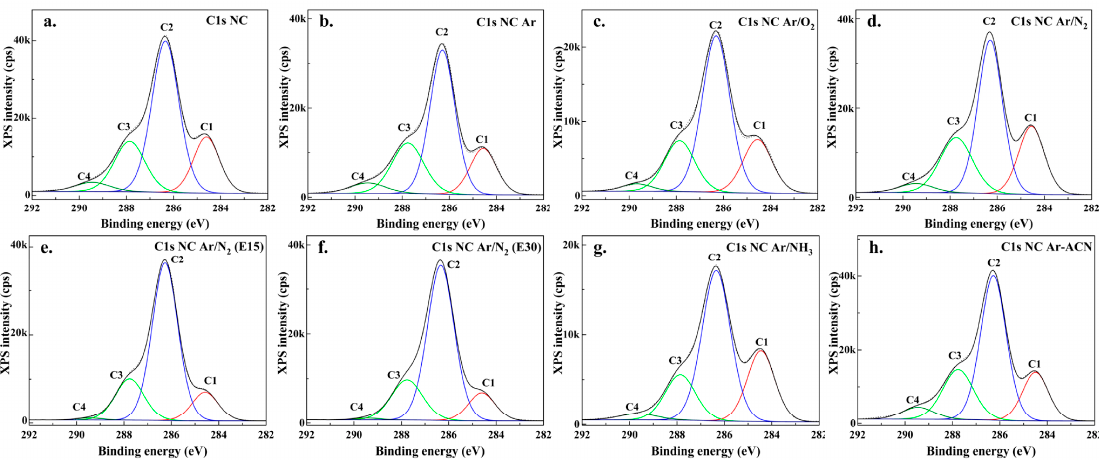
Figure 8. High resolution spectra of C1s region with deconvolution (different colored C1–C4 components) for pristine NC ( a ) and plasma treated NC: NC-Ar ( b ); NC Ar/O 2 ( c ); NC Ar/N 2 ( d ); NC Ar/N 2 (E15) ( e ); NC Ar/N 2 (E30) ( f ); NC Ar/NH 3 ( g ), and NC Ar-ACN ( h ). Table 4. Percentage of components from the total amount of carbon C1s and